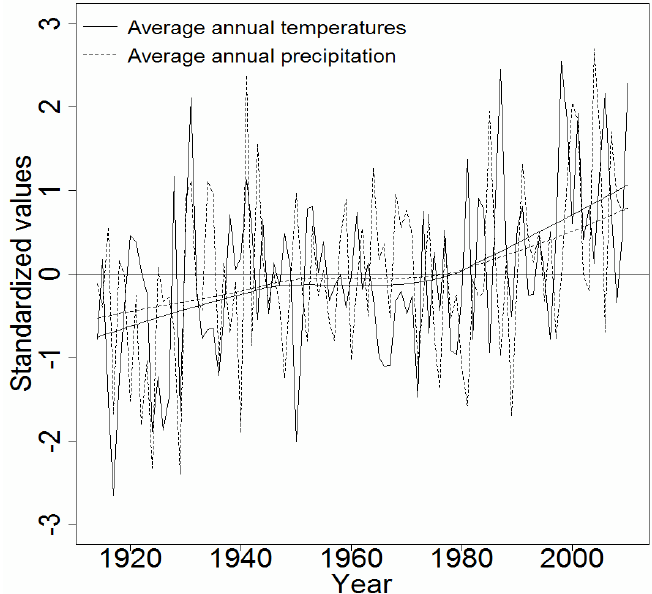
Figure 1. Mean annual temperature and precipitation (each value was standardized by subtracting the population mean and then dividing by the standard deviation) from 1915 to 2008 in the sampling area. General trends are illustrated using loess smoothing